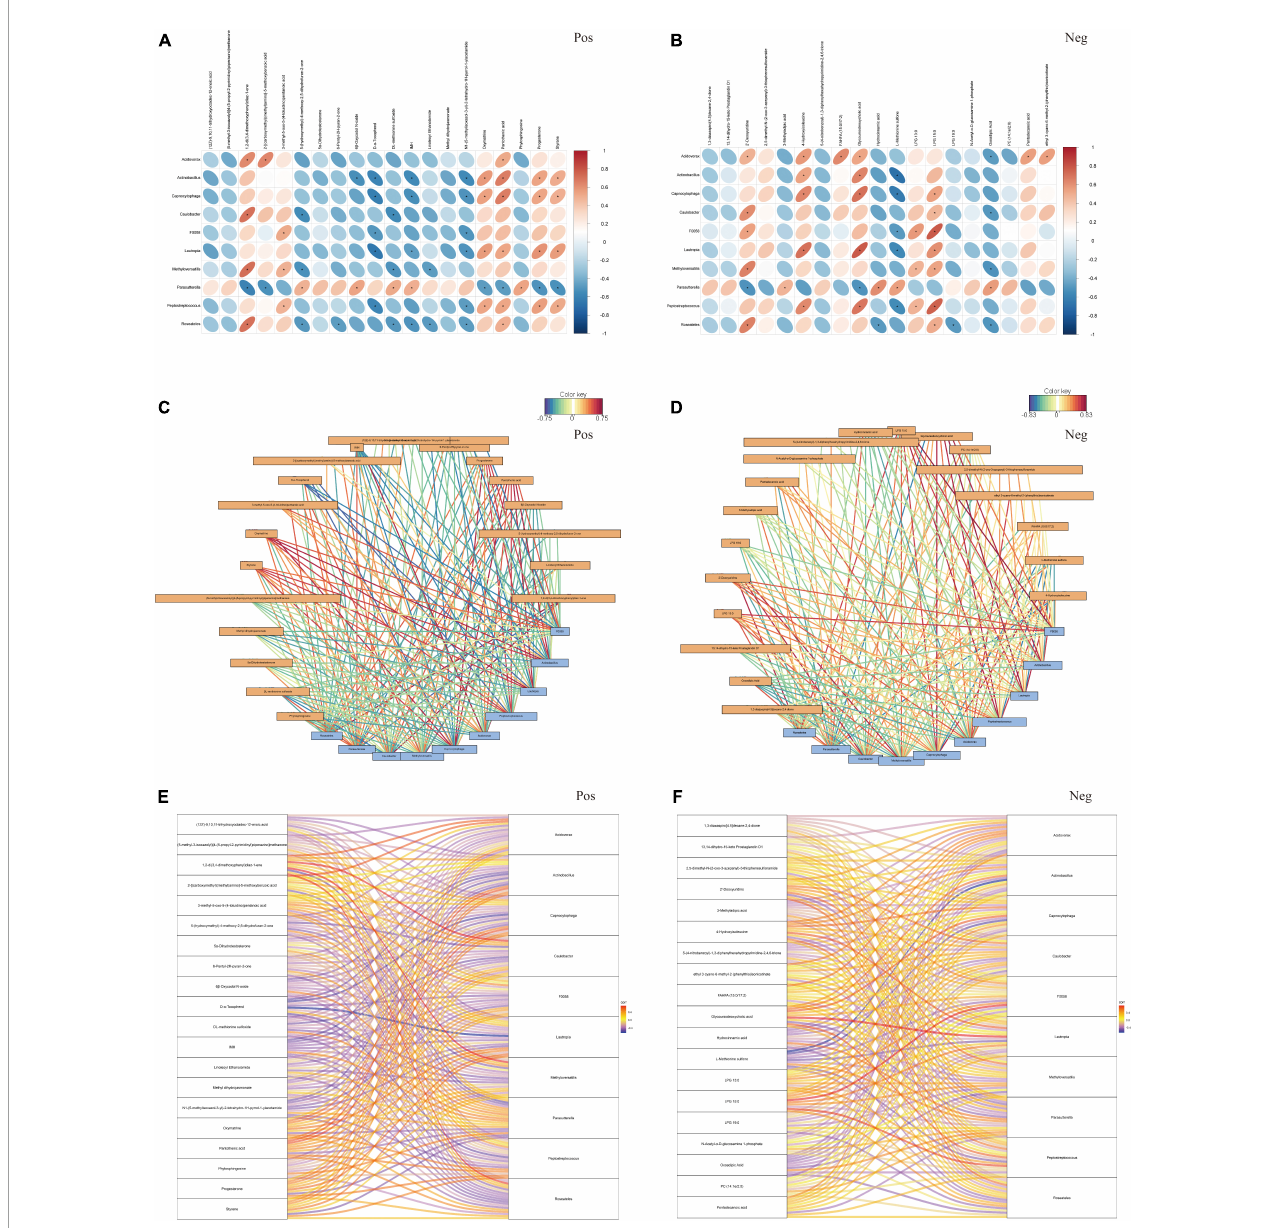
FIGURE5 The association analysis between top 10 differential fecal microbiota at genus level and top 20 differential metabolites. (A,B) Pearson correlation coefficient analysis. (C,D) Correlation network diagram analysis. (E,F) Correlation Sankey diagram analysis, by the positive and negative ion methods, separately. Red represented that the microbiota was positively correlated with metabolites, and bule represented that the microbiota was negatively correlated with metabolites. * P <